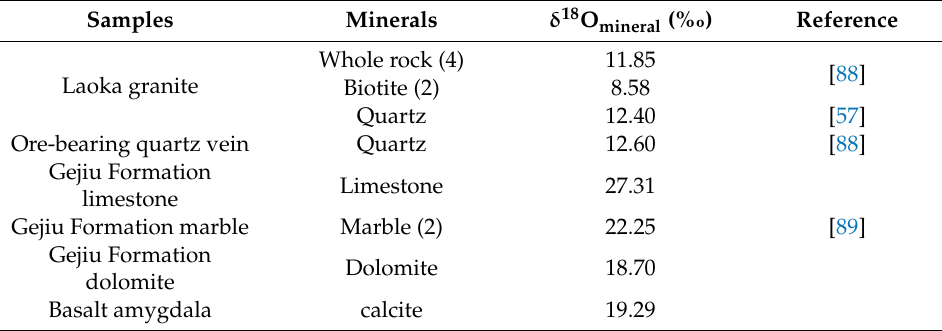
Table 7. The δ 18 O of other geological samples in Xi’ao Cu-Sn polymetallic